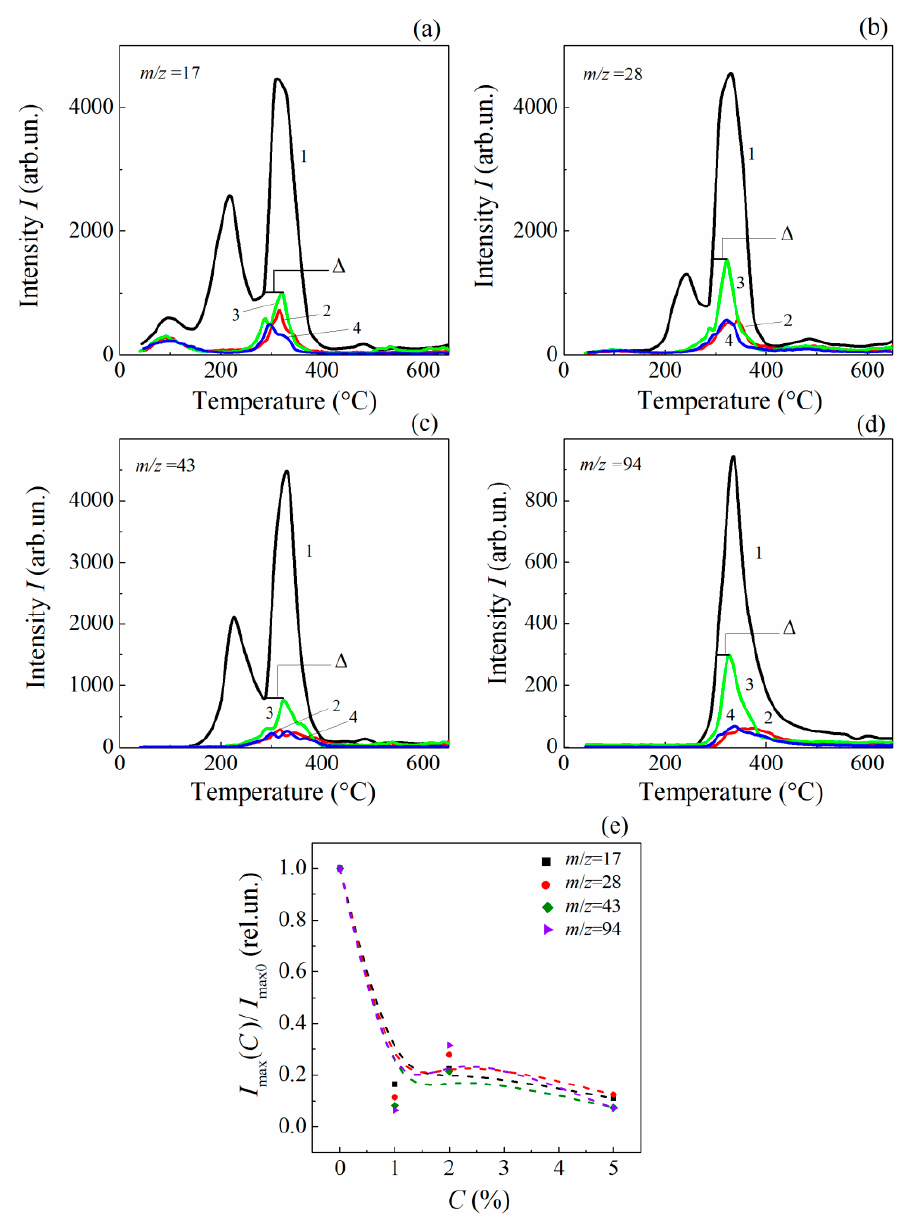
Figure 7. Temperature dependences of the desorption intensity of volatile fragments with m / z 17 ( a ), 28 ( b ), 43 ( c ), and 94 ( d ) for the neat epoxy (1) and MLG composites with C = 1% (2), 2% (3) and 5% (4); and related concentration dependences of normalized desorption ‐ peak’s intensity ( e ).